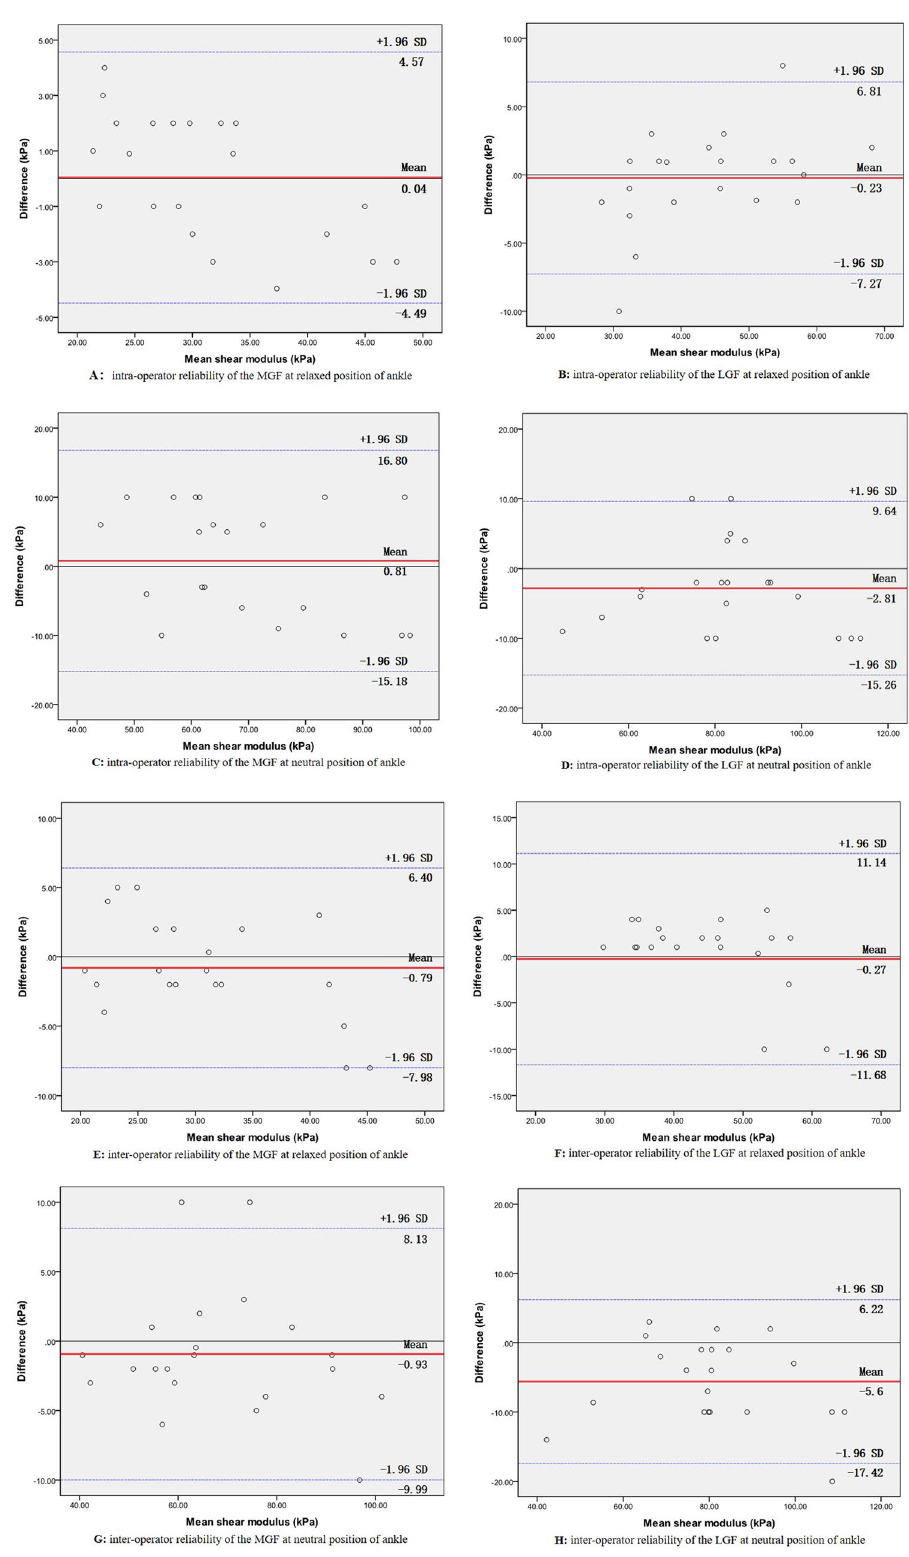
Figure 2. Bland–Altman plots of intra- and inter-operator reliability of the shear moduli of the MGF and LGF. The differences in the shear moduli between day 1 and day 5 are plotted against the mean of each participant for the MGF ( A : relaxed position; C : neutral position) and LGF ( B : relaxed position; D : neutral position). The differences in the shear moduli between operator ( A ) and operator ( B ) are plotted against the mean shear moduli of each participant for the MGF ( E : relaxed position; G : neutral position) and LGF ( F : relaxed position; H : neutral position). In each image, the continuous line is the mean difference, and the dotted lines represent two SDs above and below the mean